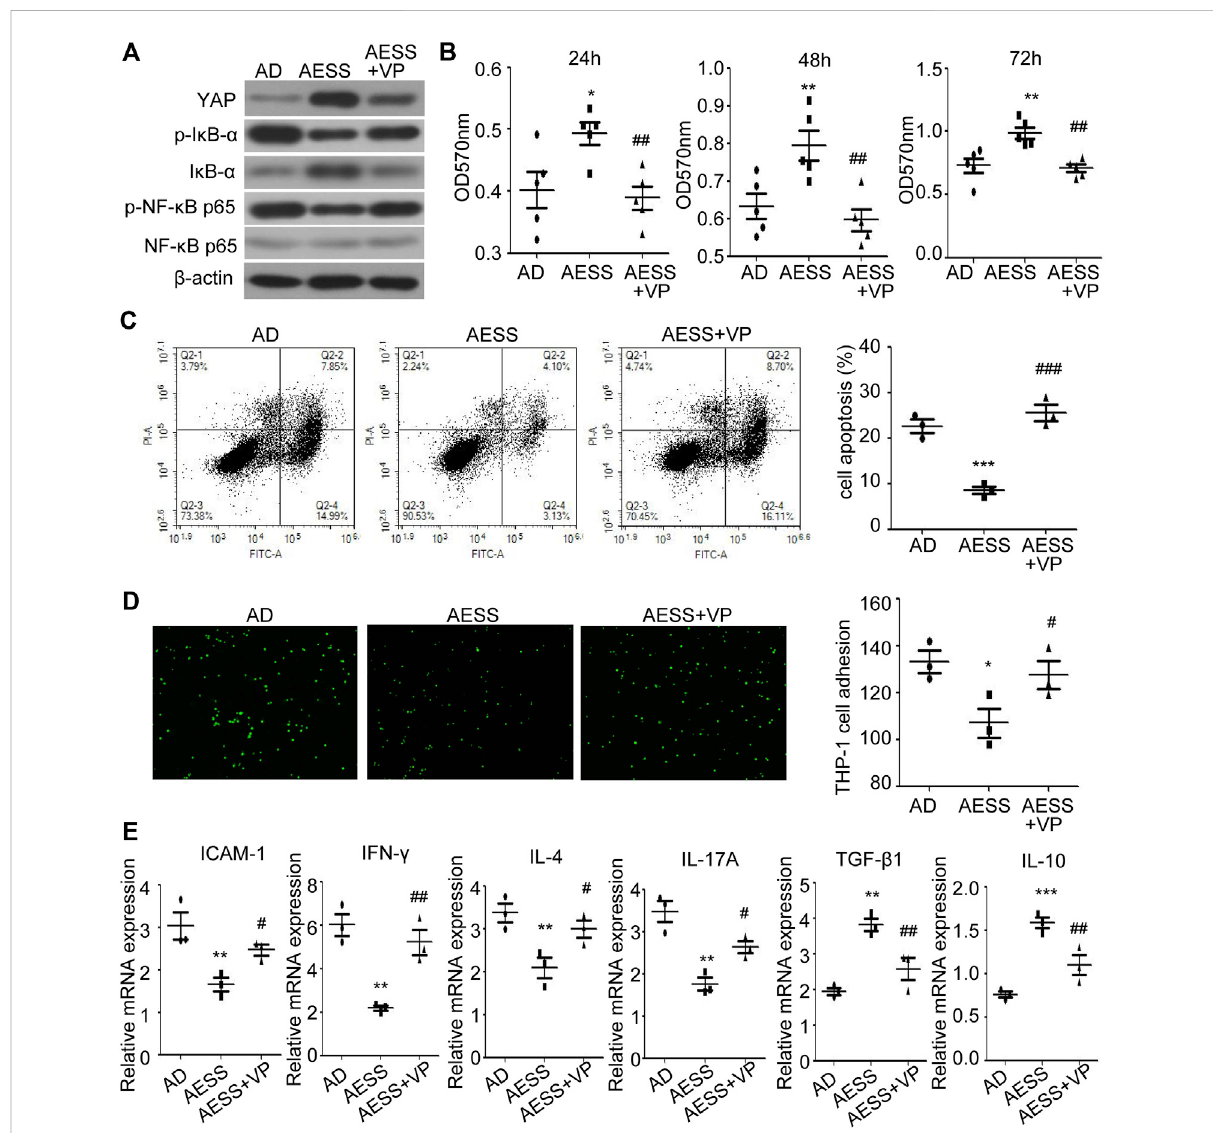
FIGURE 6 Inhibiting YAP expression could weaken the effect of AESS contained serum on AD-like cell model. (A) YAP, I κ B- α , p-I κ B- α , NF- κ B p65 and p-NF- κ Bp65expression. (B) CellproliferationwasexaminedbyMTT. (C) ApoptosiswasexaminedFACSanalysis. (D) AdhesiontoTHP-1cells(100×). (E) ICAM-1 and in fl ammatory cytokines (IFN- γ , IL-4, IL-17A, TGF- β and IL-10) mRNA expression. MTT for fi ve replicates. Cell apoptosis, adhesion assay and qRT-PCR for three replicates. AD: AD-like cells were established by HaCaT cells culture with 10 ng/ml TNF- α /IFN- γ ; AESS: AD-like cells culture with AESS contained serum; AESS + VP: AD-like cells culture with AESS contained serum and 2 μ L YAP inhibitor vertepor fi n (VP). * p < 0.05, ** p < 0.01, *** p < 0.001 v. s. AD; # p < 0.05, ## p < 0.01, ### p < 0.001 v. s.